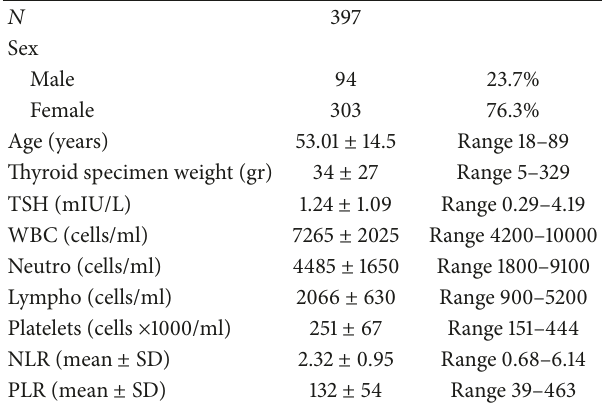
Table 1: Demographic and haematological